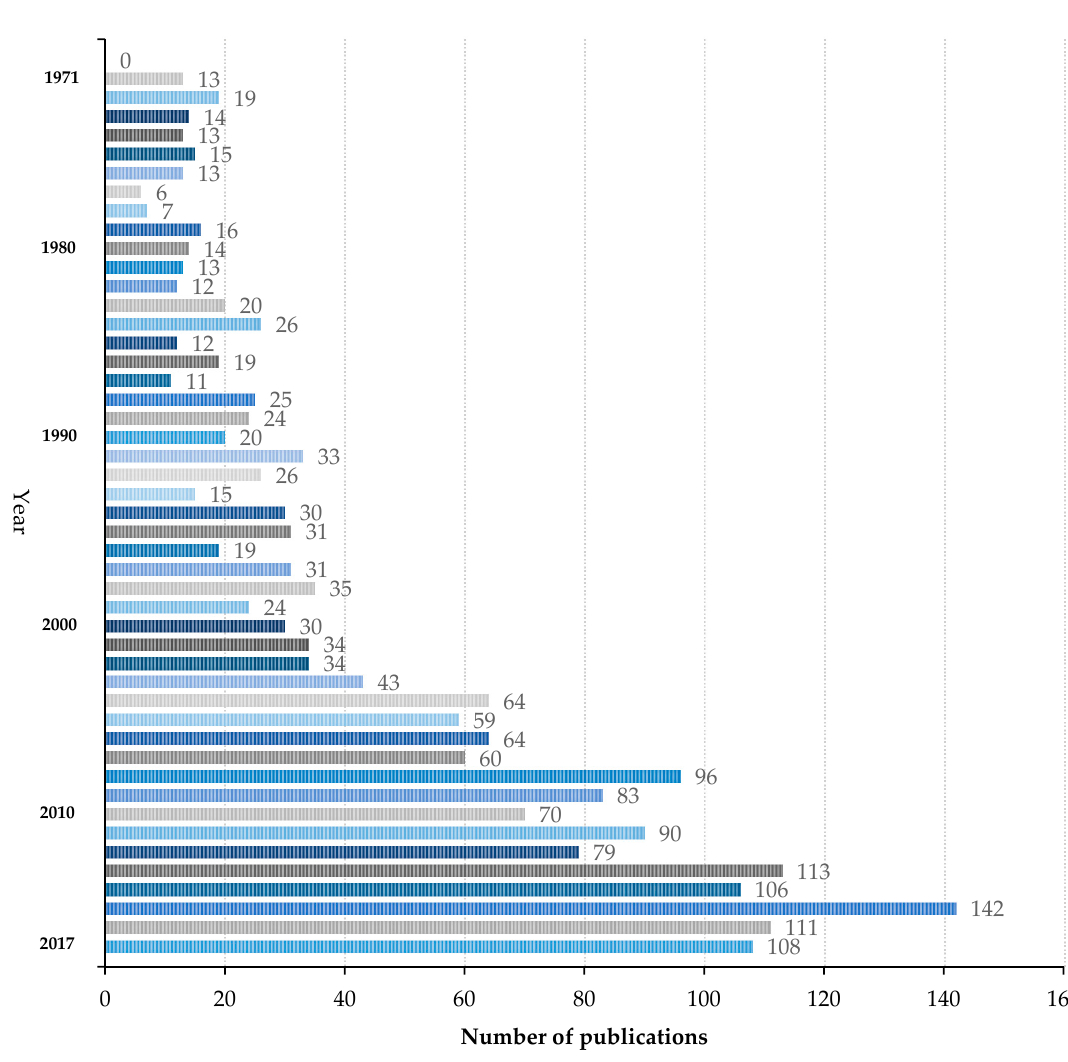
Figure 1. Increasing publications addressing neonatal palliative care.